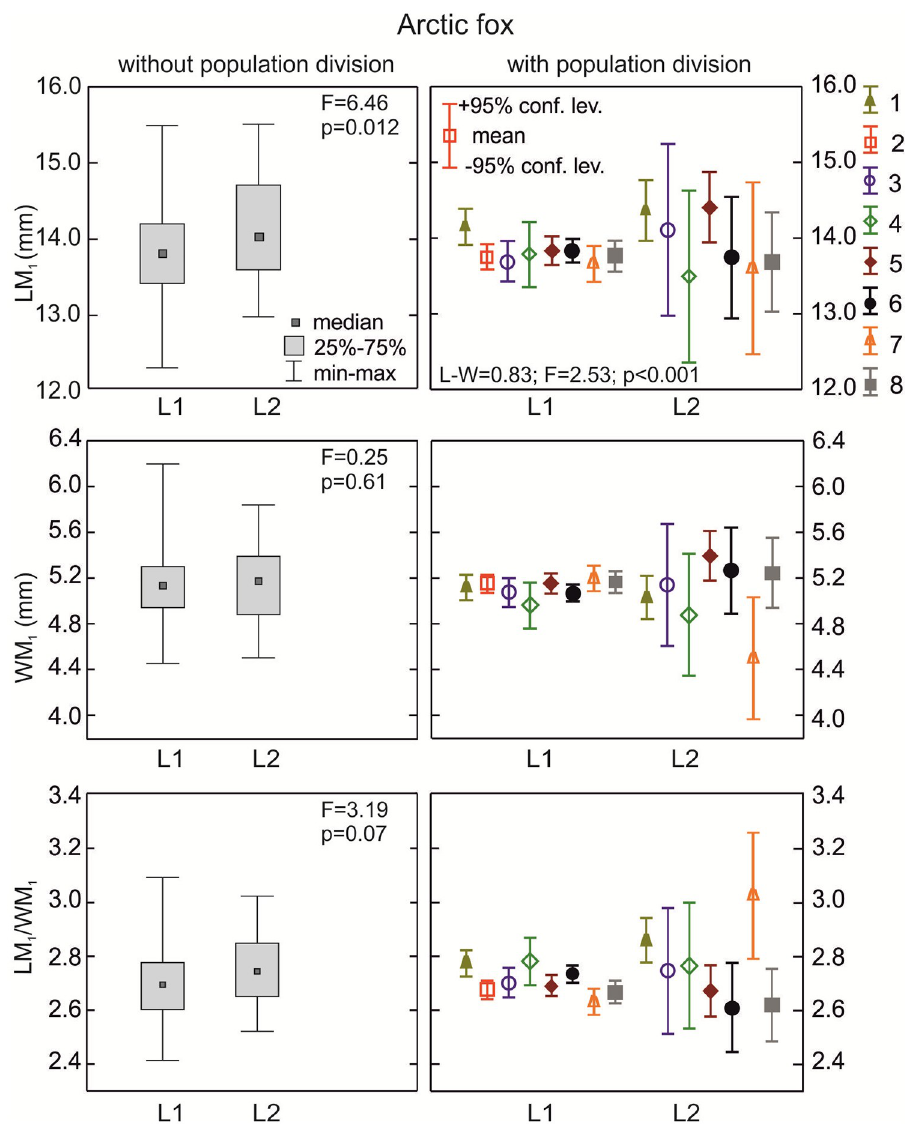
Fig 7. Comparison of median values for length, width, and size proportion of M 1 between various group L morphotypes in the arctic fox with and without population division. Illustrations of group L morphotypes are shown in Fig 2. Information about the samples can be found in Table